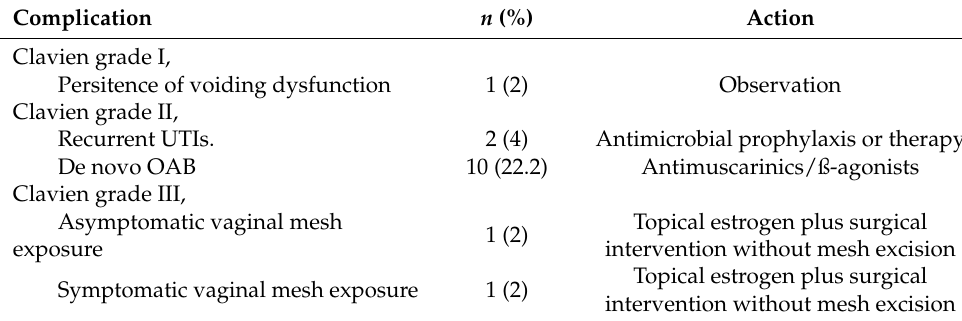
Table 5. Clavien–Dindo classification of long-term